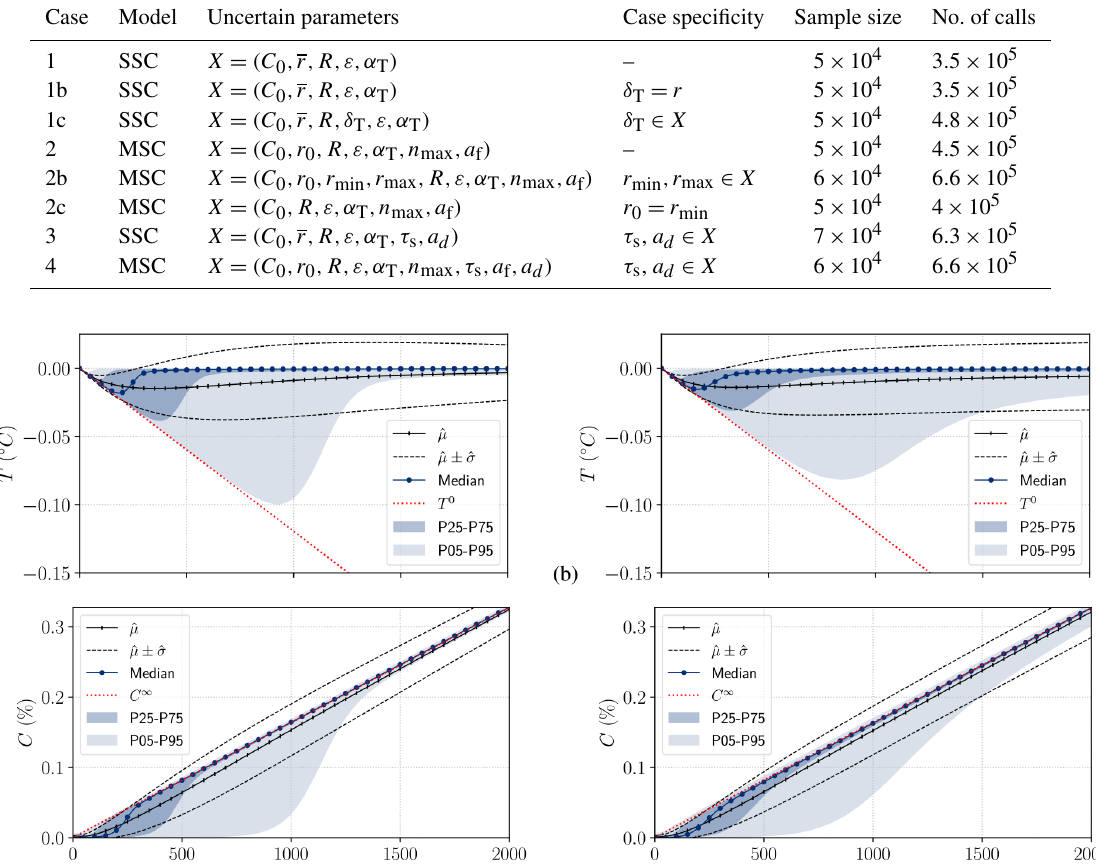
Table 3. List of Monte Carlo simulations and their associated input random vectors X , sampling size and number of function calls. Seeding rate and buoyancy velocity are set to τ s = 0 and a d = 0 in cases 1 and 2.